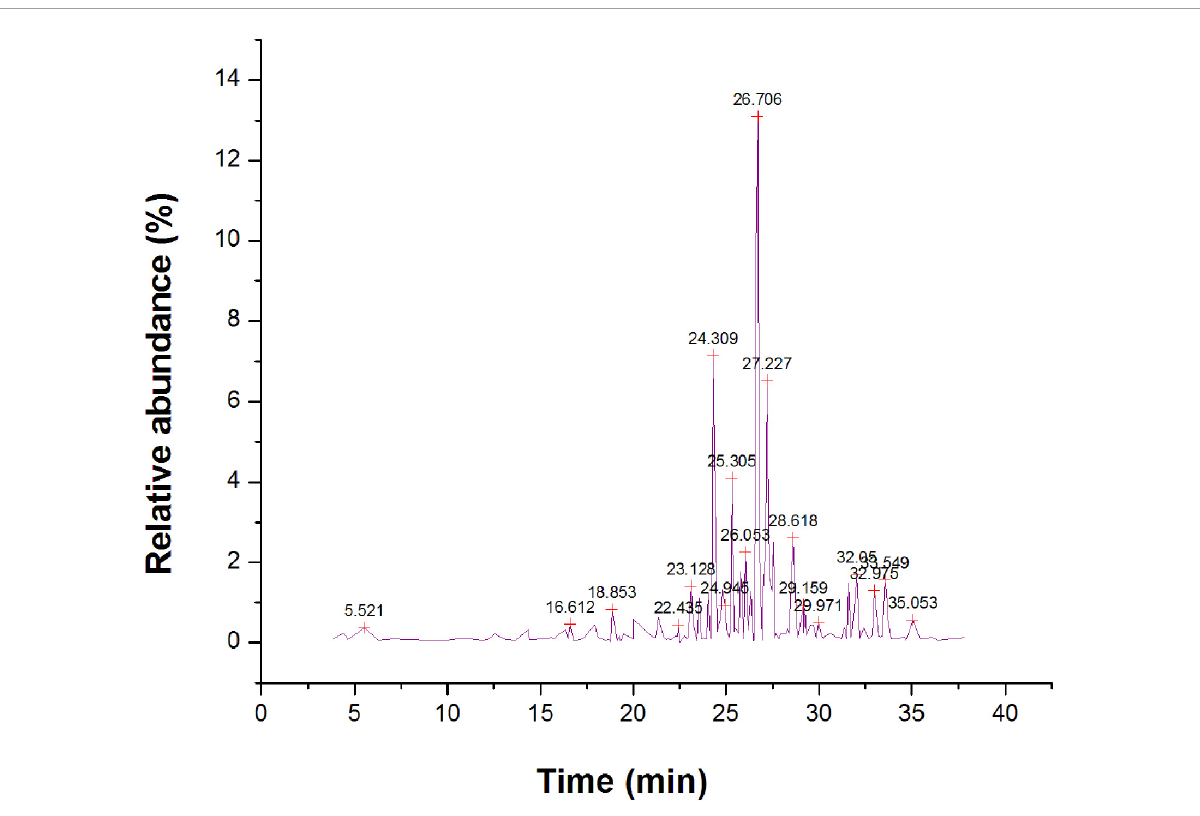
FIGURE7 Gas chromatography-mass spectrometer (GC-MS) chromatogram for major compounds of methanol root extract of Skimmia anquetilia